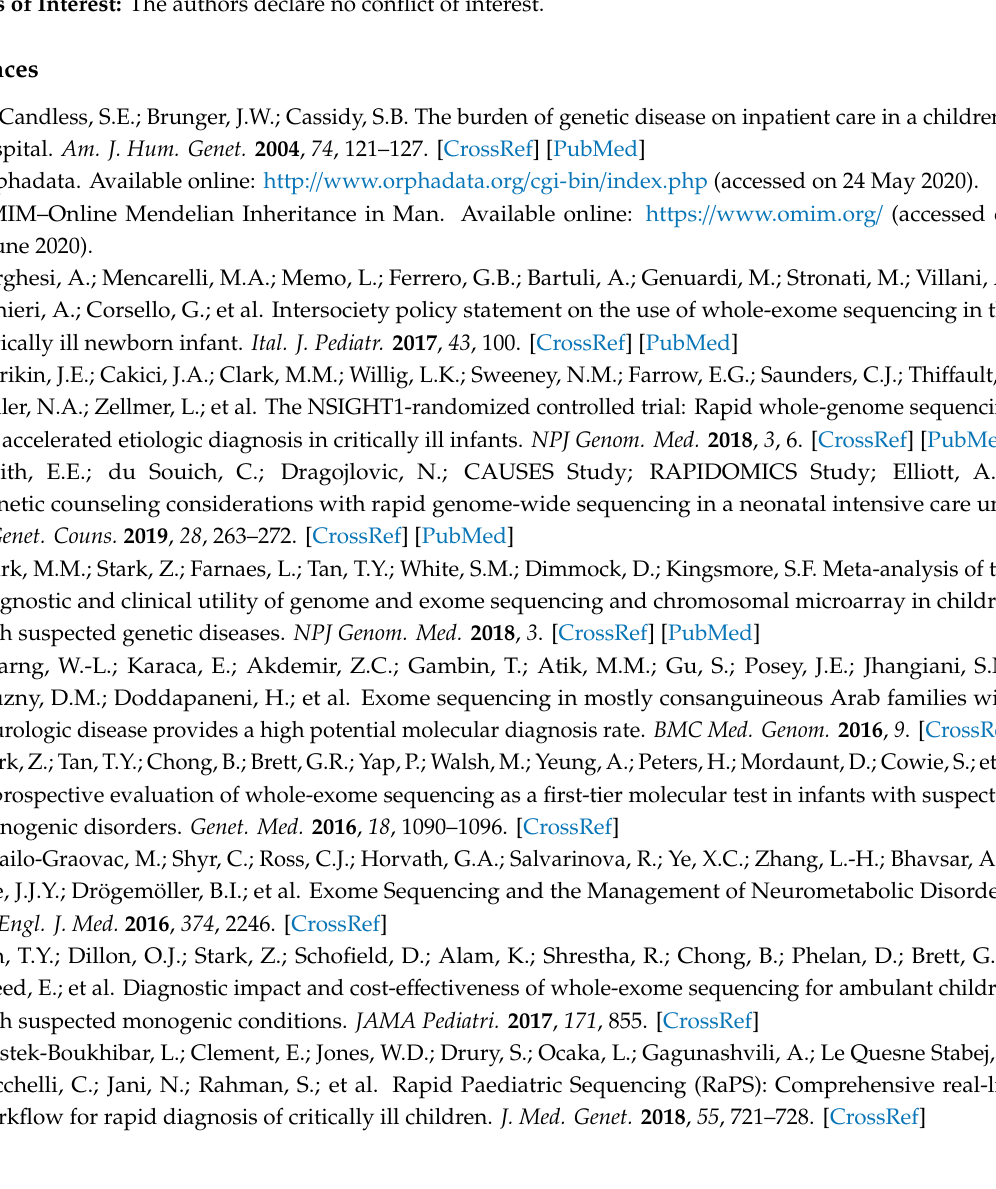
Table S1: Variants pathogenicity